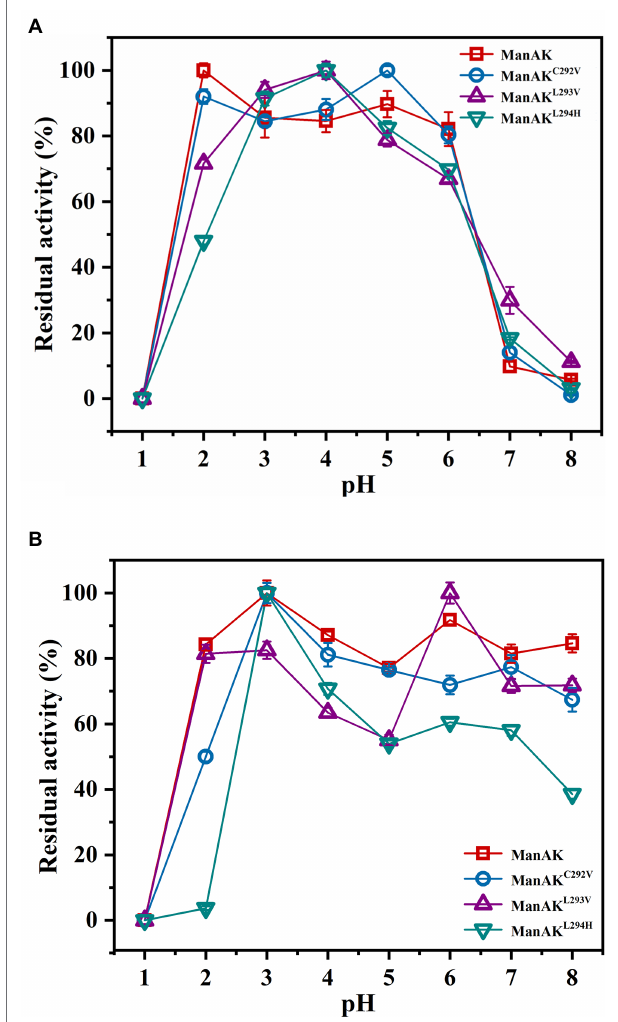
FIGURE 3 | Effects of pH on activity and stability of recombinant β -mannanases. (A) The pH optimum was determined in glycine–HCl buffer (pH 1.0–4.0), sodium acetate buffer (pH 4.0–6.0), and Tris-HCl buffer